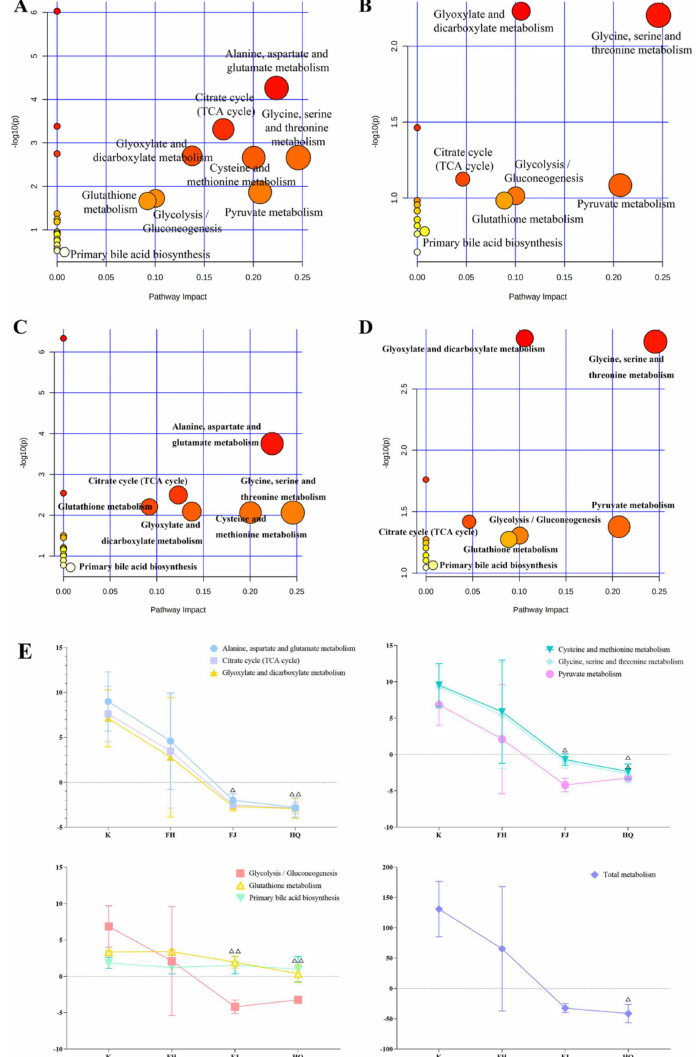
Figure 8. Metabolic pathways of blood and urine samples in rats with nephrotic syndrome and their effects after administration. Note: ( A ) serum sample metabolic pathways of NS rats; ( B ) urine sample metabolic pathways of NS rats; ( C ) serum metabolic pathways regulated by FH; ( D ) urine metabolic pathways regulated by FH; ( E ) effect values of metabolic pathways in serum and urine samples of K group and drug administration group. Compared with FH group, (cid:52) p < 0.05, (cid:52)(cid:52) p <